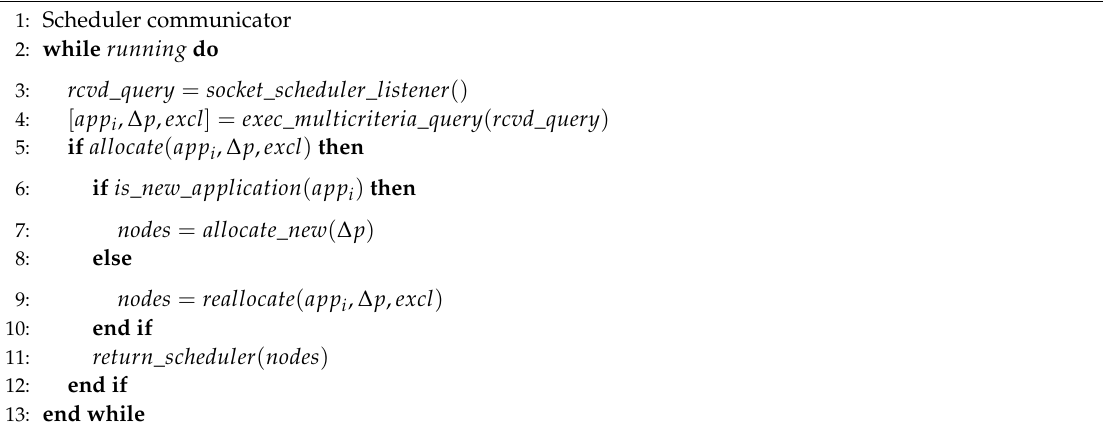
Algorithm 2 Scheduler communicator algorithm in a LIMITLESS DaeMon